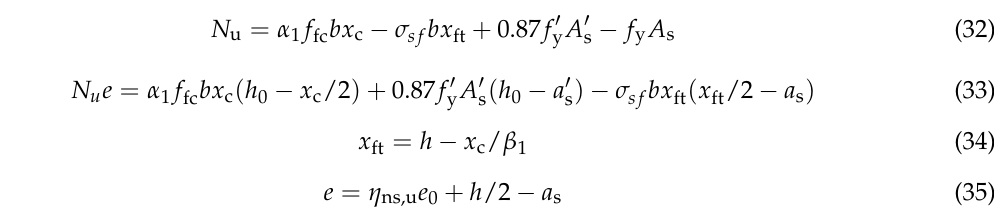
Table 10. The tested and calculated ultimate force of the test columns.